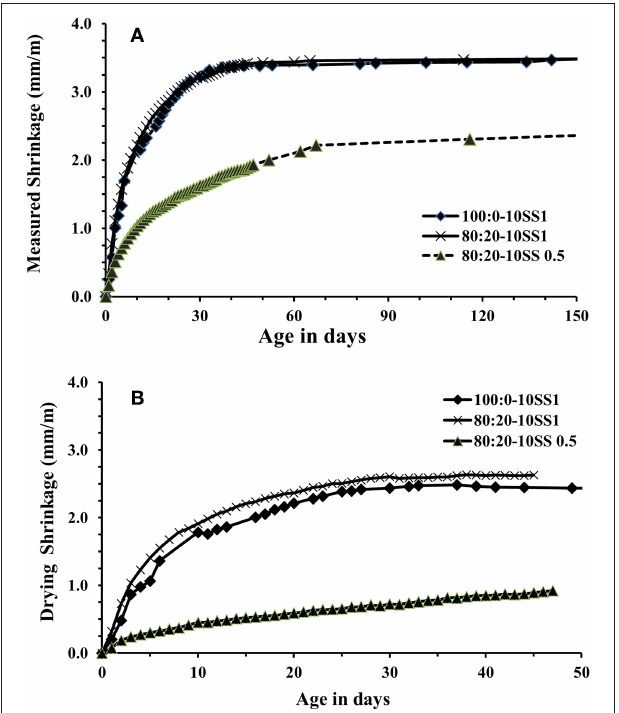
FIGURE 9 | XRD results for 28 day old alkali activated pastes based on BFS/FA activated with 10%SS and data for anhydrous slag and fly ash for comparison. Q, quartz; M, mullite; HM, hematite; MG, maghemite; CS, C-A-S-H; HT, hydrotalcite; NS, N-A-S-H.